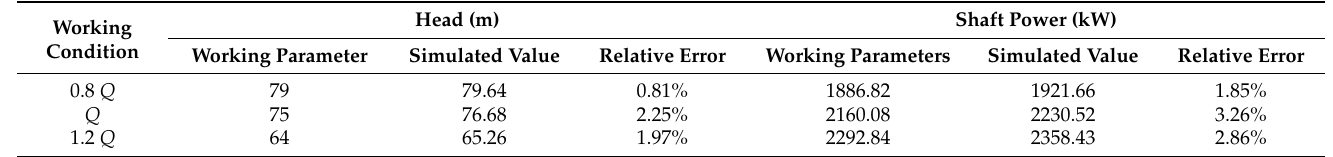
Table 2. Errors between simulated values and working parameters.